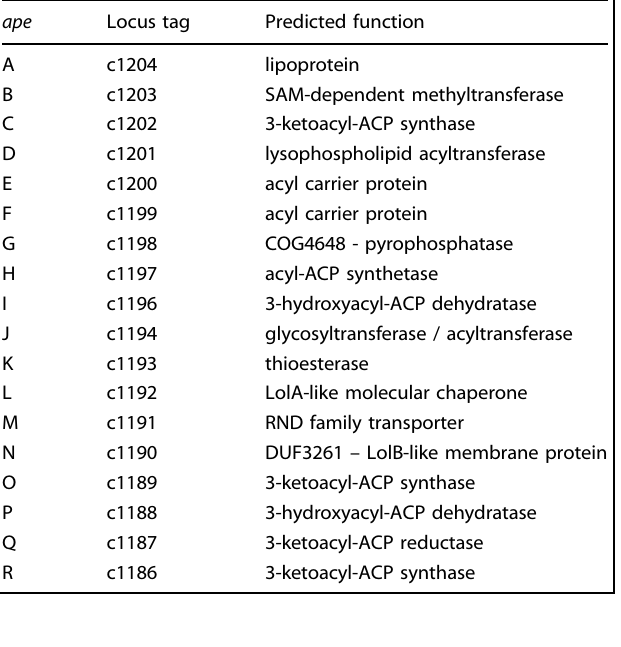
Table 1. Predicted gene functions for the APE Ec BGC.